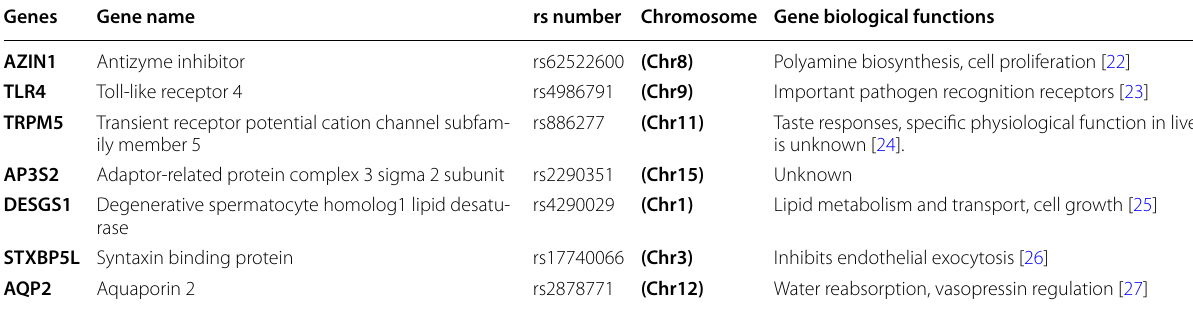
SNP single-nucleotide polymorphism, rs accession number on databases referring to specific SNPs